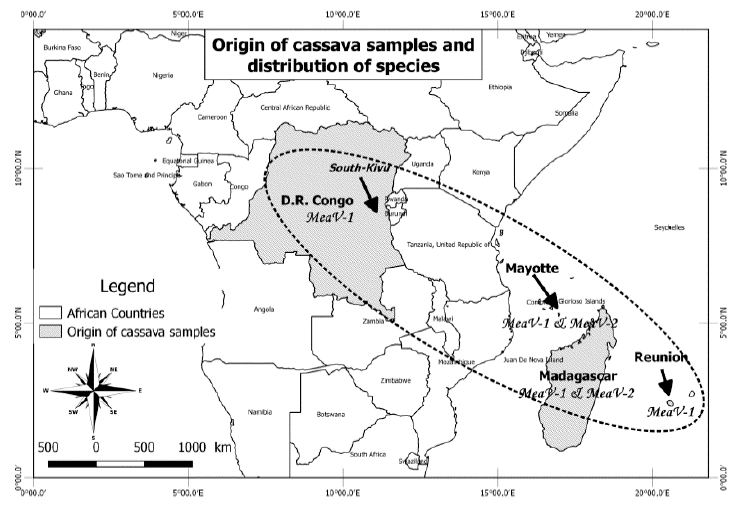
Figure 4. Geographic repartition of the two novel cassava ampelovirus species (MEaV-1 and MEaV-2) according to the country of origin of positive samples.